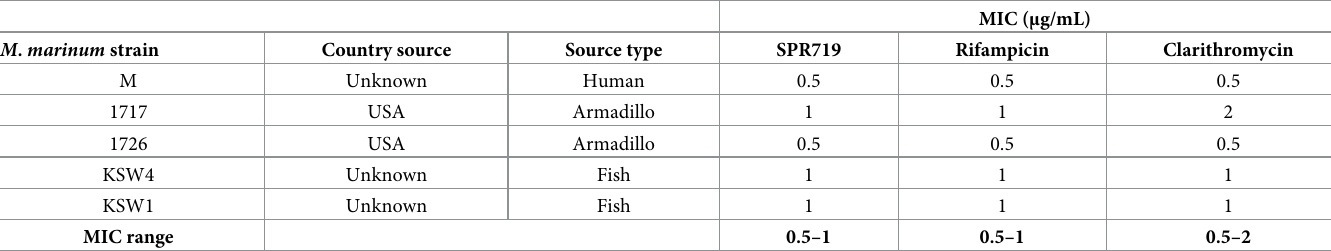
Table 2. M . marinum strains used in this study and their